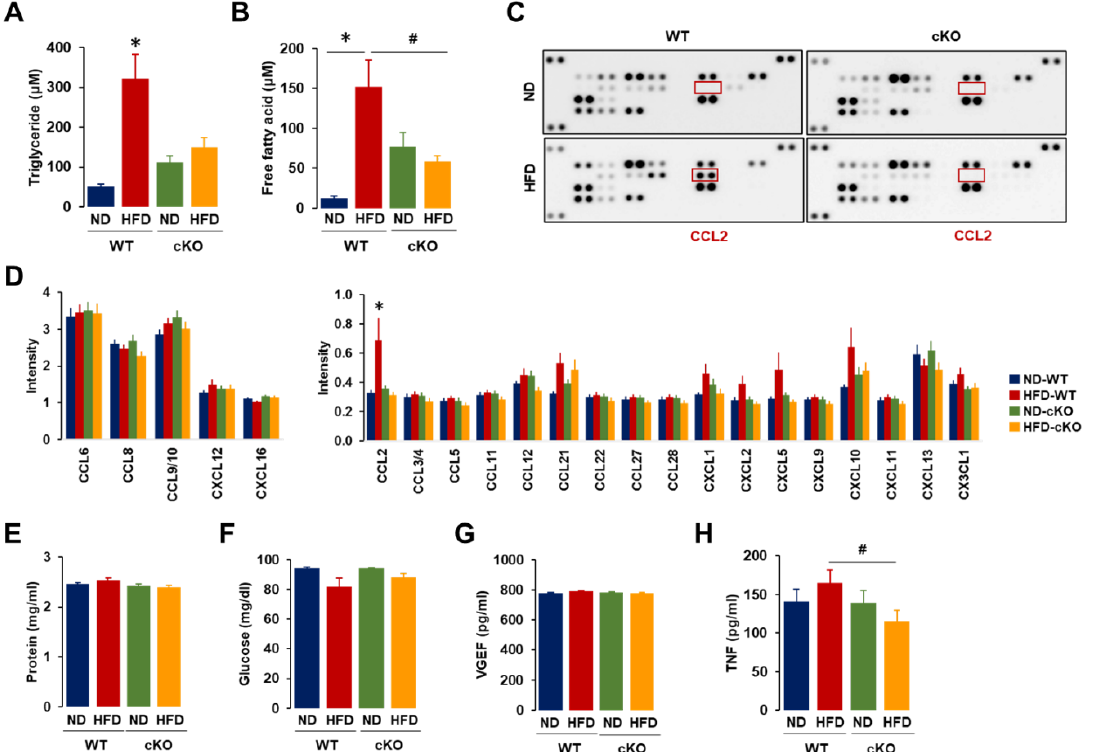
Figure 4. Biochemical characteristics of OC-induced ascites in a postmenopausal diet-induced obese mouse model between CXCR2 WT and cKO mice. ( A ) Triglyceride and ( B ) free fatty acid levels in OC-induced ascites of ND-WT ( n = 8), ND-cKO ( n = 6), HFD-WT ( n = 8), and HFD-cKO ( n = 7) mice using quantitative colorimetric assays with duplicate measurements. ( C ) Chemokine signatures in ascites of ND-WT, ND-cKO, HFD-WT, and HFD-cKO mice by proteomic array. ( D ) Intensity of chemokine expression profiles in OC-induced ascites of ND-WT, ND-cKO, HFD-WT, and HFD-cKO mice. ( E ) Total protein, ( F ) glucose, ( G ) VEGF, and ( H ) TNF levels in OC-induced ascites of ND-WT, ND-cKO, HFD-WT, and HFD-cKO mice. * and # indicates significant increases and decreases ( p ≤ 0.05), respectively, between groups as analyzed by ANOVA and Tukey’s pairwise comparison tests.